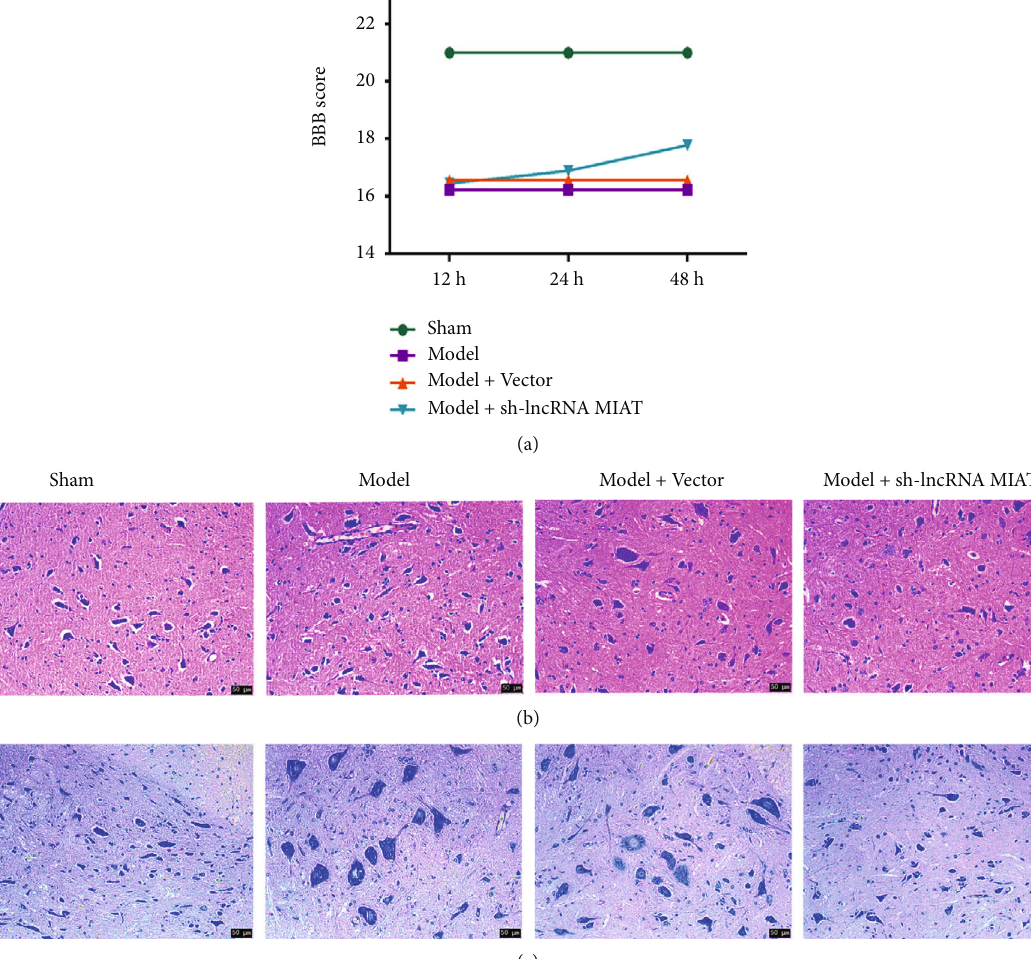
Figure 3: E ff ects of sh-lncRNA MIAT on the behavior and spinal cord pathology of SCIRI rats. (a) Rat behavior BBB score. (b) HE staining (200 × ), and (c) Nisin staining (200 ×